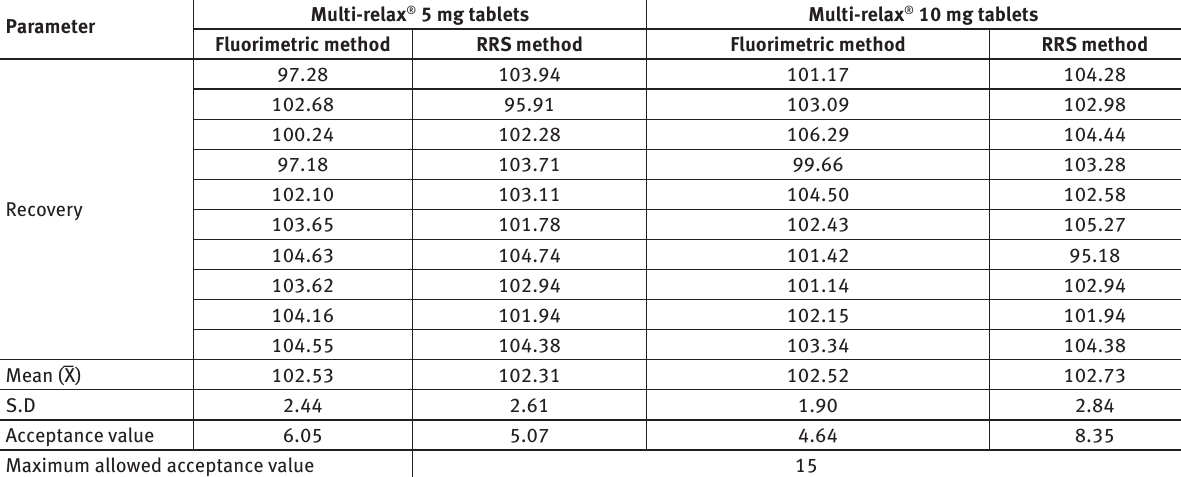
Table 5: Content uniformity test for CZP in its commercial tablets by the proposed spectroscopic methods